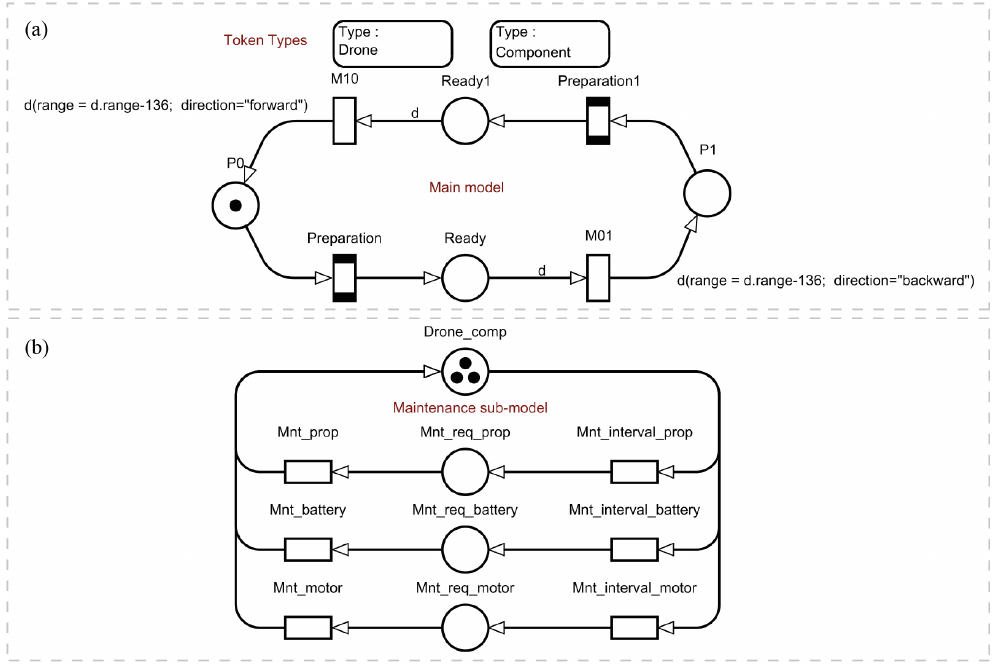
Figure 3. The upper hierarchical level of the model is presented. There are two parts: ( a ) The main monitoring model that simulates the flight of a drone from one point to another, as well as preflight preparation. ( b ) The maintenance model that simulates the life cycle of drone components such as propellers, batteries and